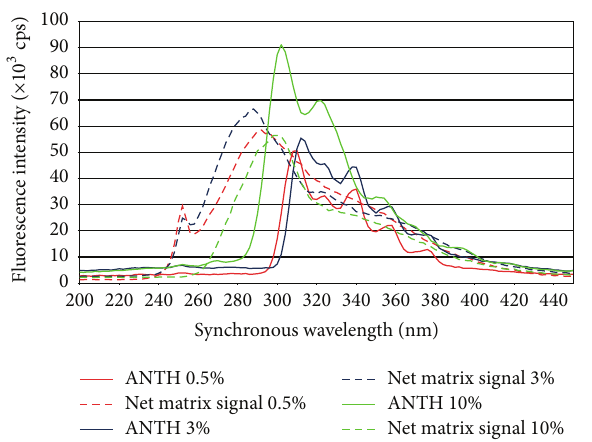
Figure 3: Synchronous spectra with Δ𝜆 = 150 nm of the 180 ng/mL anthracene solutions and the net matrix signal fluorescence inten-